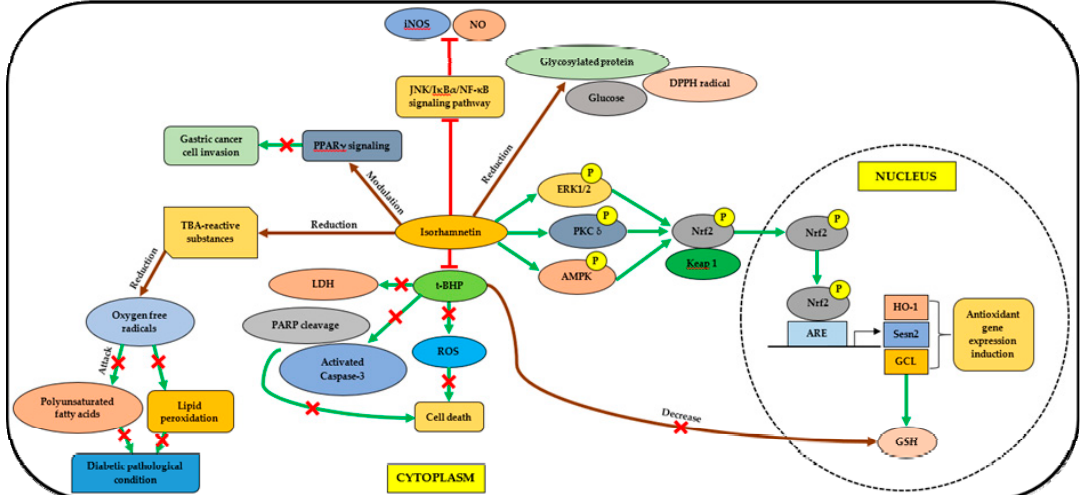
Figure 2. The mechanisms of antidiabetic activity exhibited by isorhamnetin. TBA, thiobarbituric acid; LDH, lactate dehydrogenase; PARP, poly (ADP-ribose) polymerase; ROS, reactive oxygen species; t-BHP, tert-butyl hydroperoxide; PPAR γ , peroxisome proliferator-activated receptor gamma; JNK, c-Jun N-terminal kinase; I κ B α , nuclear factor of kappa light polypeptide gene enhance in B-cells inhibitor, alpha; NF- κ B, nuclear factor kappa-light-chain-enhancer of activated B cells; iNOS, inducible nitric oxide synthase; NO, nitric oxide; DPPH, 1,1-Diphenyl-2-picrylhydrazyl; ERK1/2, extracellular signal-regulated kinase 1 or 2; PKC δ , protein kinase C delta; AMPK, 5 ′ adenosine monophosphate-activated protein kinase; Nrf2, nuclear factor erythroid 2-related factor 2; Keap1, Kelch-like ECH-associated protein 1; ARE, antioxidant response element; HO-1, hemeoxygenase 1; Sesn2, sestrin2; GCL, glutamate-cysteine ligase; GSH, glutathione. Adapted from Yang et al. [53].